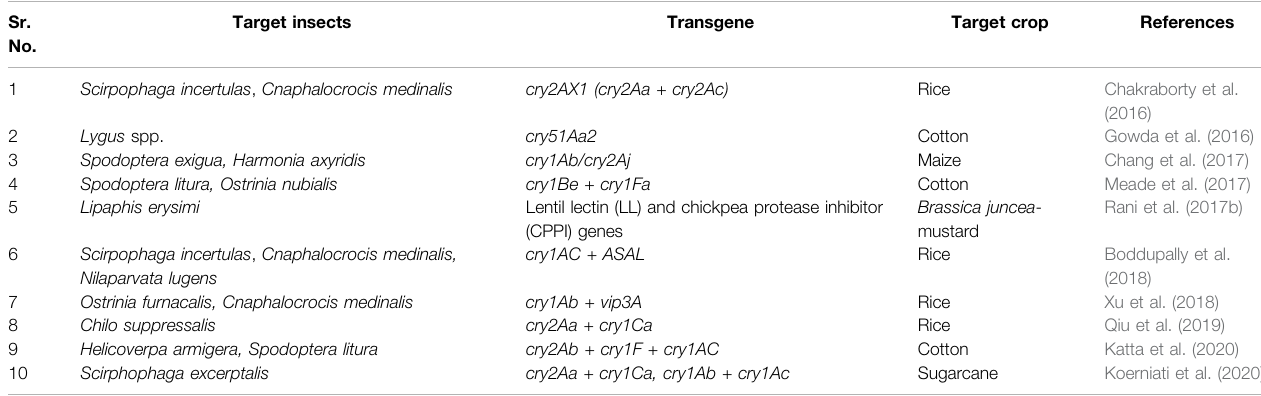
TABLE 4 | Fusion proteins for insect resistance in crop plants. Sr.